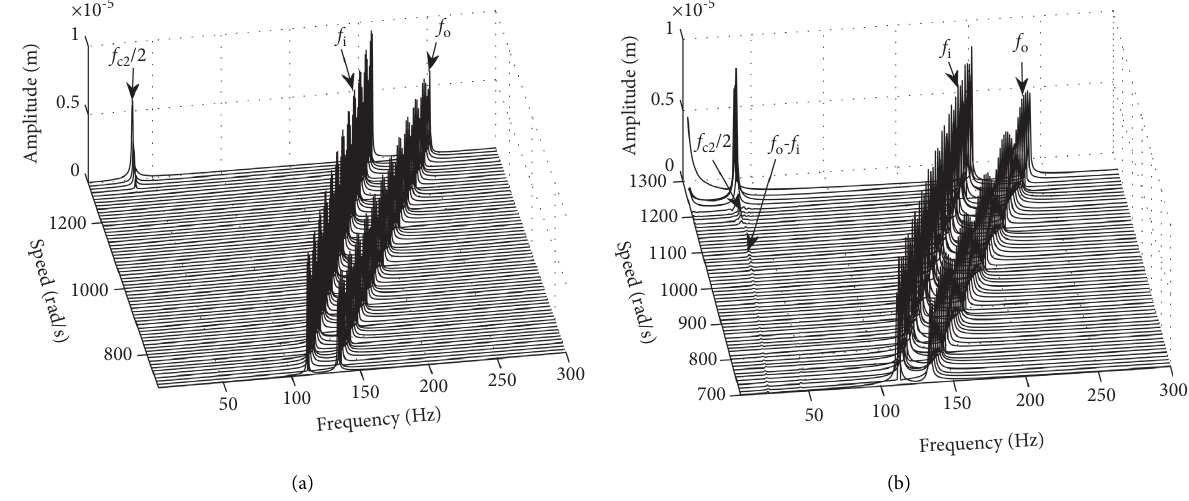
Figure 12: Waterfall plots of the MSDS with K